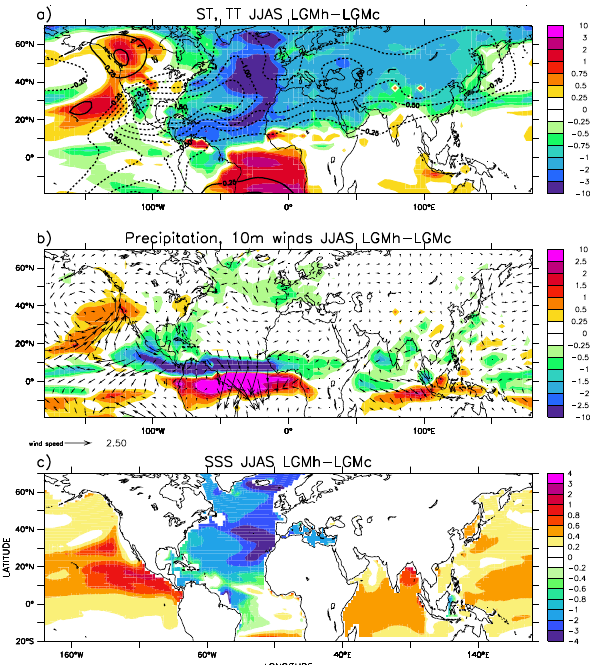
Fig. 4. Differences between LGMh and LGMc (hosing minus con- trol experiment) of JJAS (June to September mean) (a) surface tem- perature (ST, shaded) and tropospheric temperature averaged from 200 to 500hPa (TT, contours), (b) precipitation and 10m winds, (c) sea surface salinity